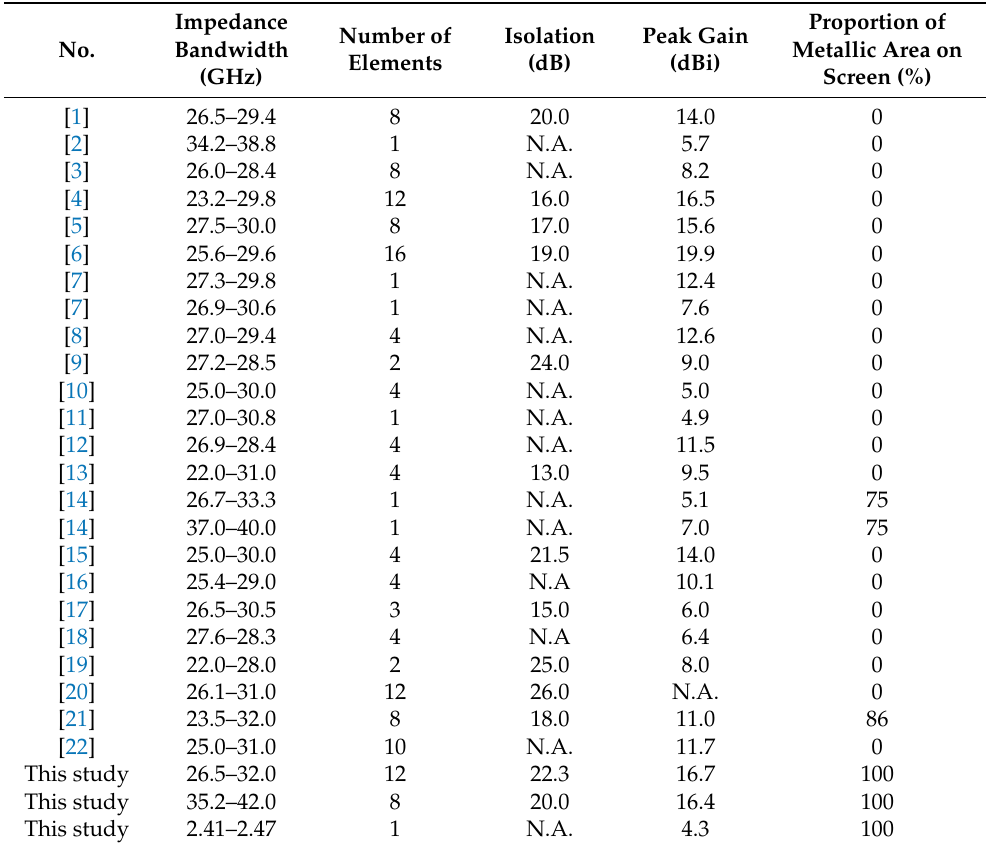
Table 1. Comparison of millimeter-wave 5G antennas for mobile